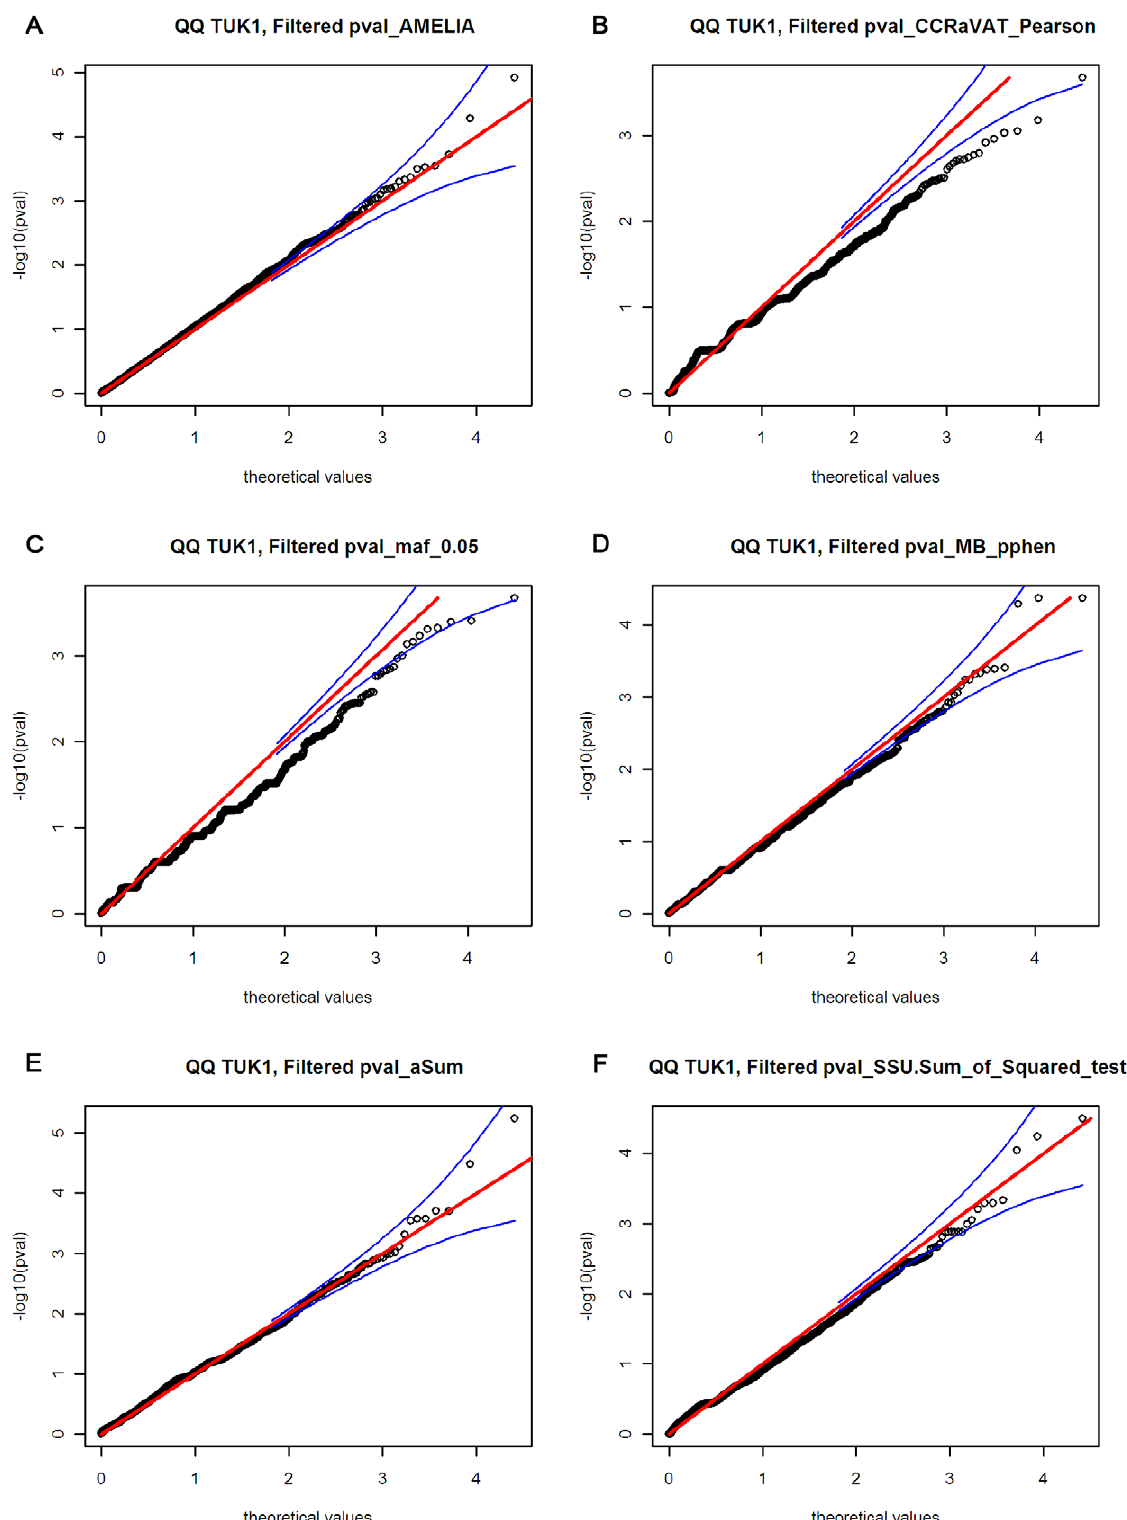
Figure 1. Quantile–quantile plots for the six different variant burden analysis methods. Quantile–quantile plots are shown for: (a) AMELIA, (b) CCRaVAT, (c) fixed filter test, minor allele frequency , 0.05, (d) Madsen-Browning with polyphen weights, (e) Han and Pan aSumtest, (f) SSU, sum-of-squares test (Han and Pan).